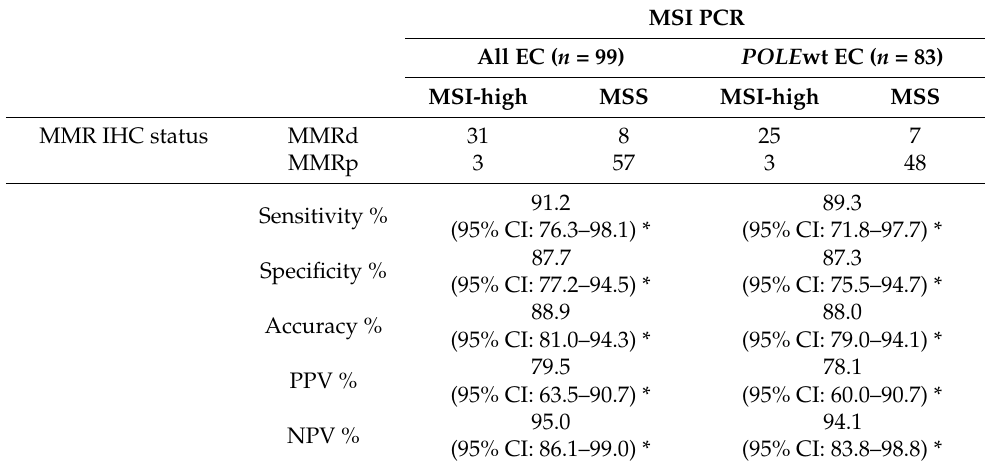
Table 3. Agreement between MMR IHC status and MSI PCR testing.